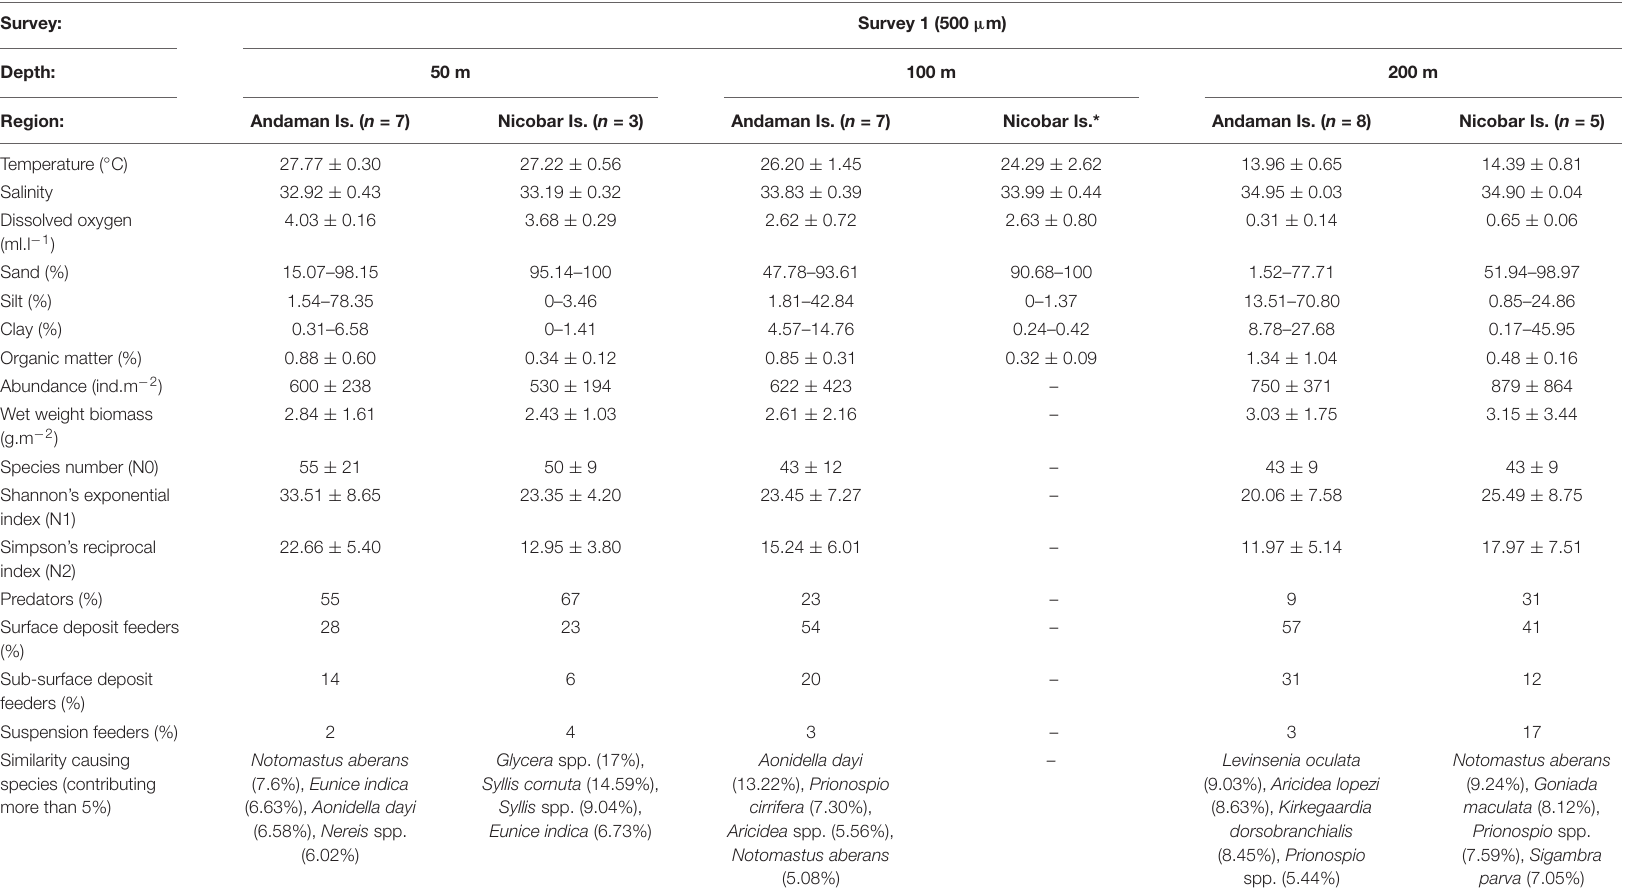
TABLE 4A | Biological characteristics of polychaete species assemblages in Survey 1 (500 µ m) with prevailing environmental conditions [mean ± SD, n = No. of samples].